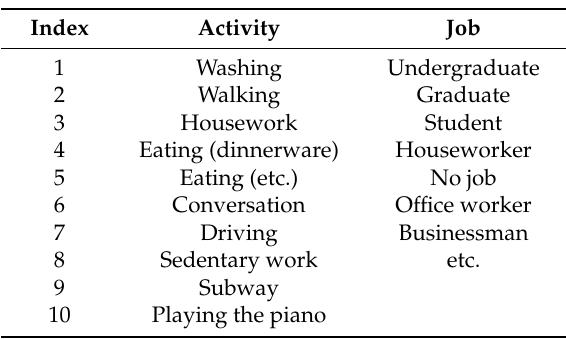
Table 7. Index of activities and jobs.